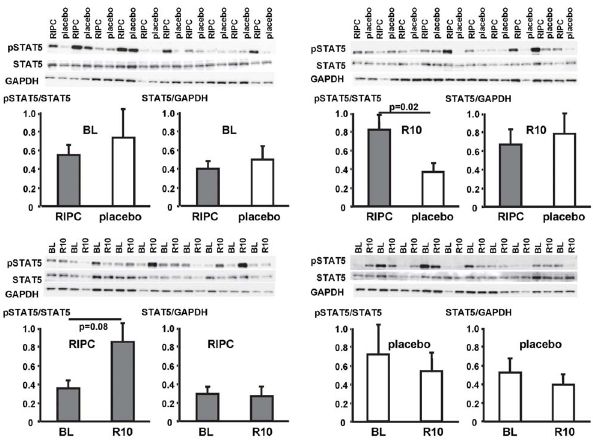
Figure 9. Activation of signal transducer and activator of extracellular signal-regulated protein kinase 1/2 (ERK1/2) by ischemia/reperfusion. Original Western blots of phosphorylated (p) and total ERK1/2 content in myocardial biopsies obtained at baseline (BL) before initiation of cardiopulmonary bypass and at 5–10 min reperfusion (R10) from patients undergoing remote ischemic precon- ditioning (RIPC) or not (placebo). Immunoreactivitiy of pERK1/2 was normalized to the respective total protein. Ratios are presented in bar graphs.